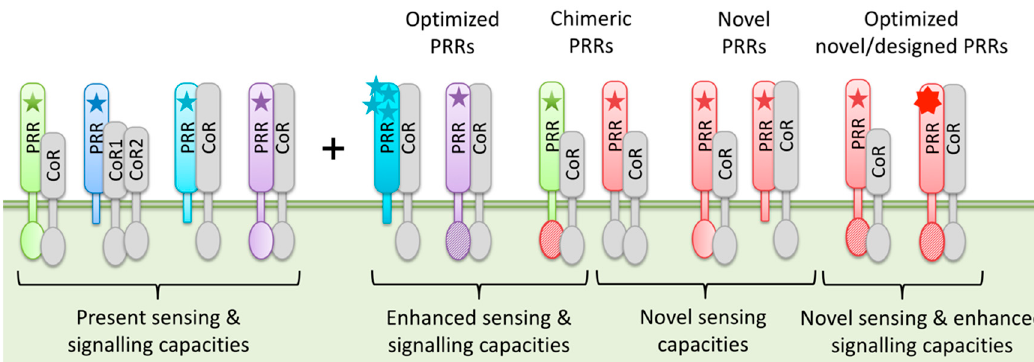
Figure 2. Schematic representation of potential PRR transfer and engineering options. PRR-mediated sensing of MAMPs/DAMPs (star symbols) and PRR signaling capacities can be enhanced by optimization of endogenous PRRs or introduction of novel, chimeric or even “designer” PRRs. This equips plants with additional MAMP/DAMP sensing and improved signaling capacities and results in enhanced PTI against a broad spectrum of invaders.